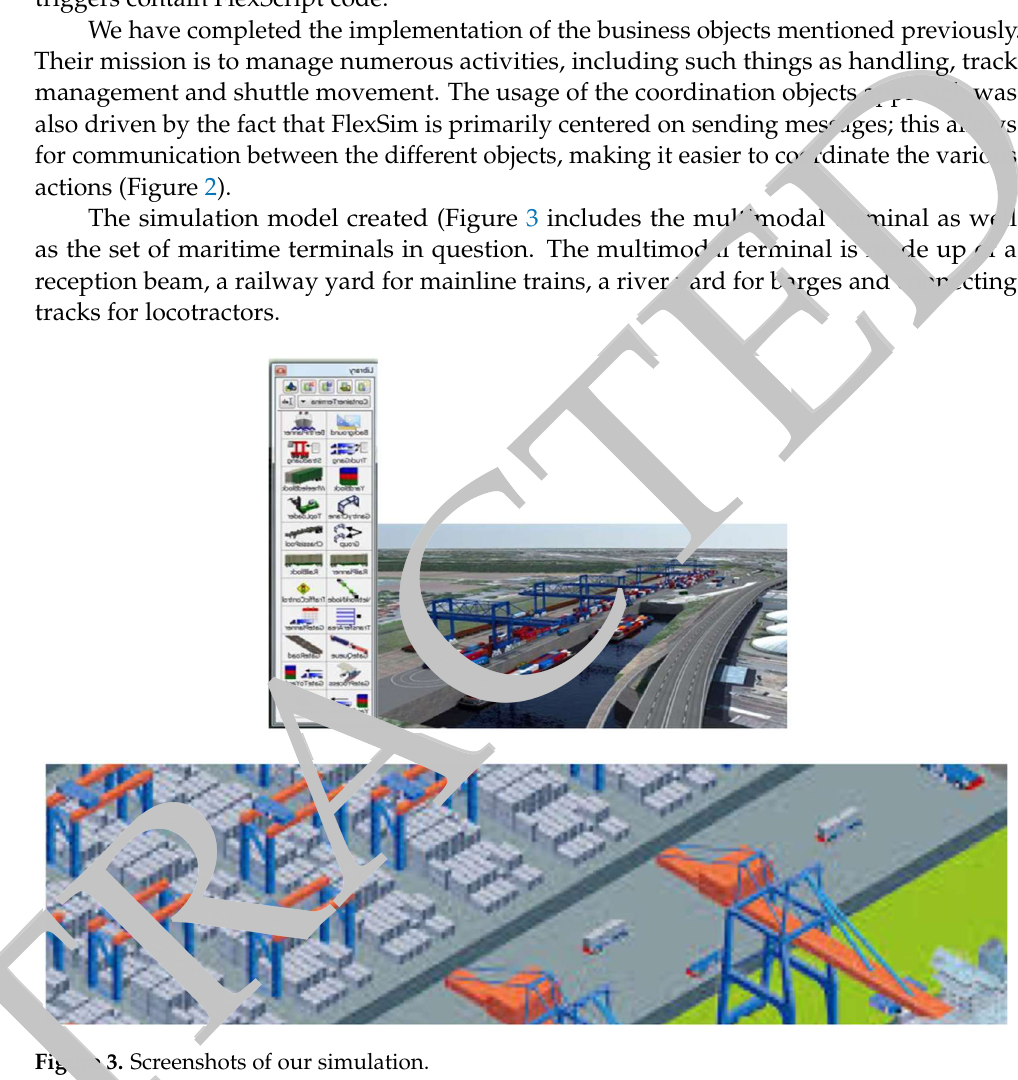
Figure 3. Screenshots of our